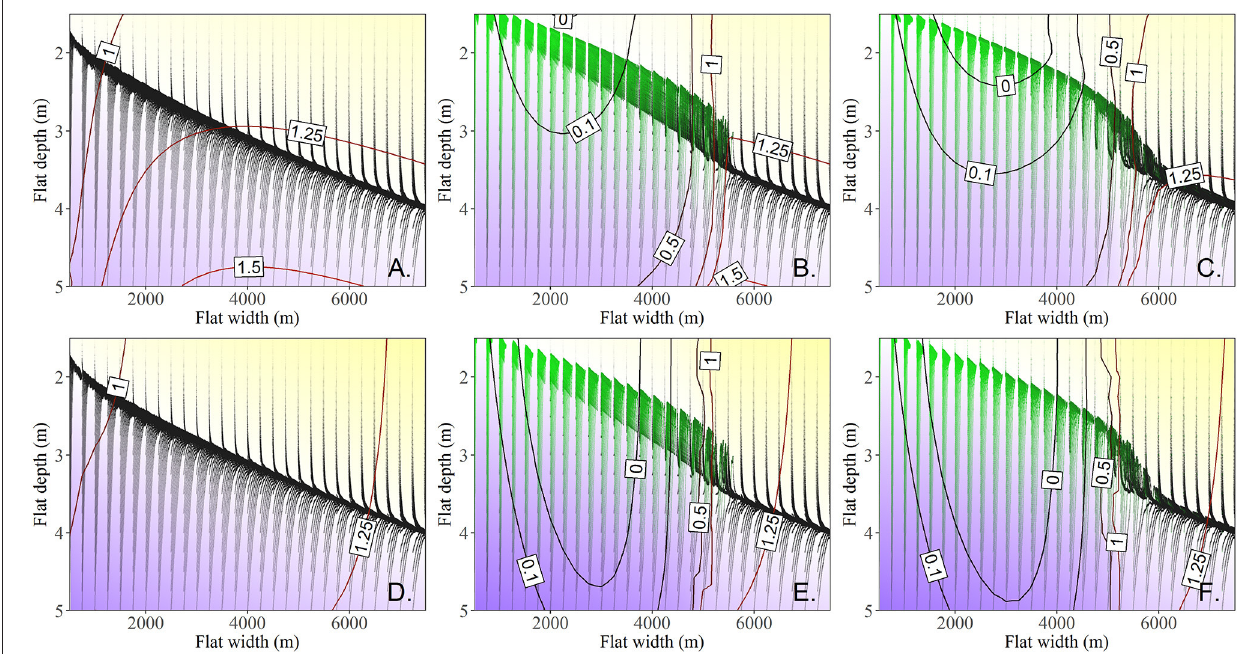
FIGURE 7 | 300 year long trajectories initiated at tidal flat depths of 1.5–5m and tidal flat widths of 0.5–7.5km (RSLR = 4mm year − 1 , C o = 30mg L − 1 ) in 0.25m and 0.25km increments respectively. Yellow regions indicate where trajectories result in overall deepening of the tidal flat whereas blue regions represent shallowing system trajectories. The white region represents the vertical nullcline. Contours of the lateral erosion rate (total lateral erosion rate (A–C) , final five year average erosion rate (D–F) are shown. (A) and (D) , are systems with no seagrass allowed. (B,E) , Seagrass is allowed to establish, or senesce. (C,F) , Seagrass is initiated at 500 shoots m − 2 and allowed to establish, or